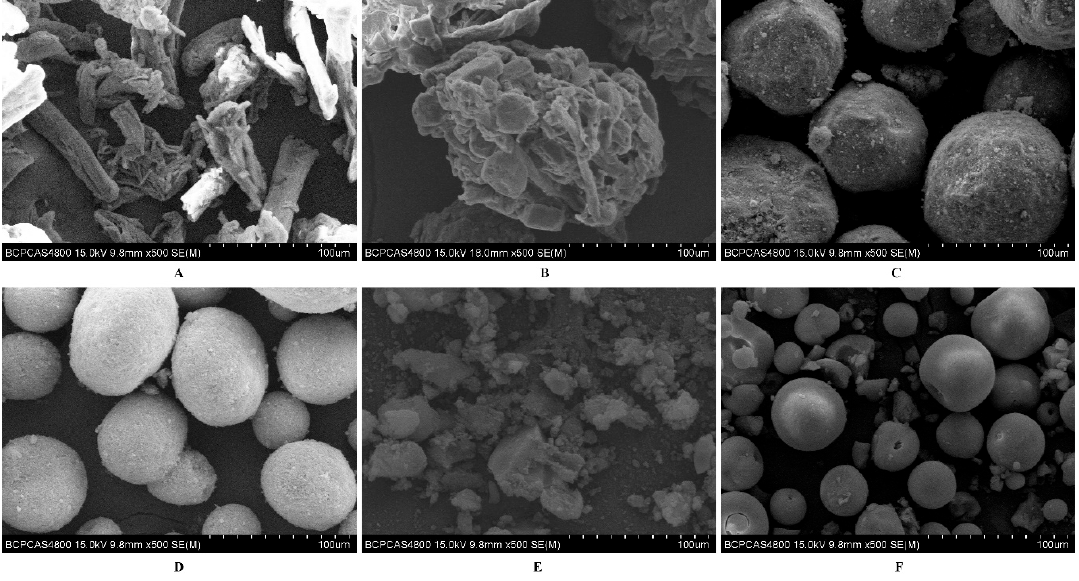
Figure 8. Total content of impurities after incubation at 60 °C/92% RH away from light for 1, 5, or 10 days for drug-excipient chemical compatibility study.